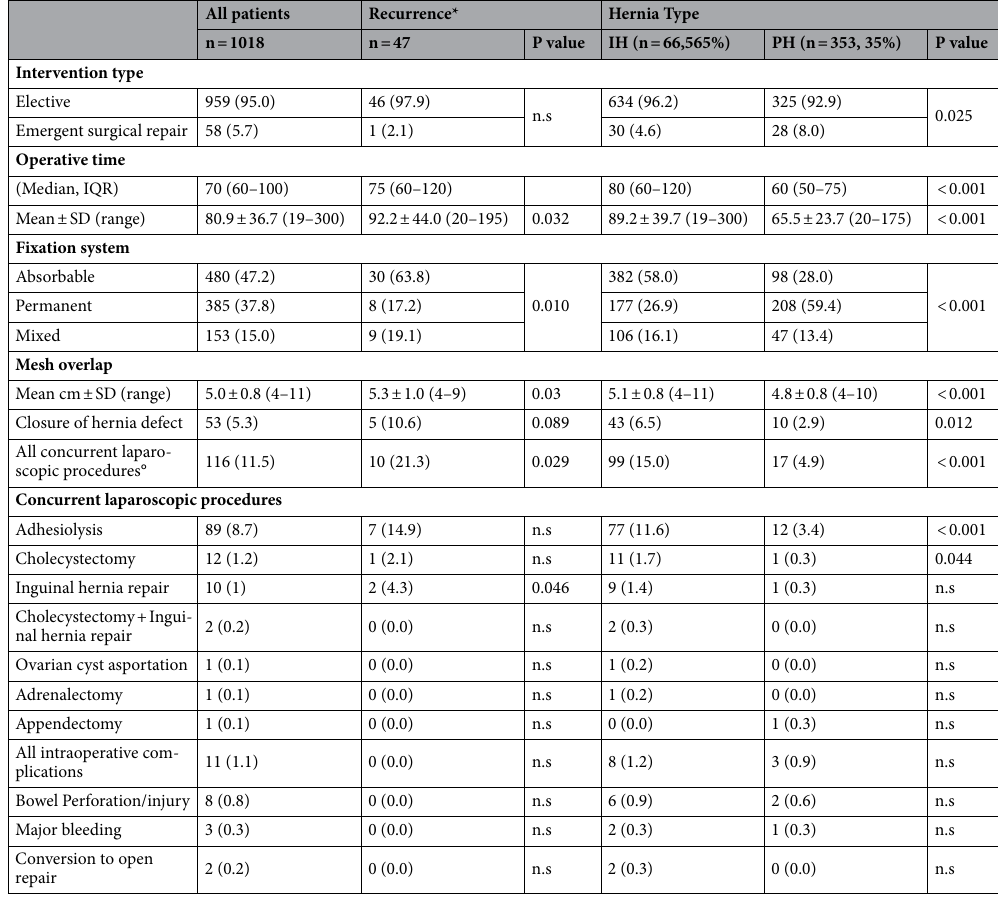
Table 2. Intraoperative details for all patients (n = 1018), recurrences* (n = 47) with significative risk factors (p value), and comparison between IH (n = 665) and PH (n = 353). Data presented were n (%), unless specified. n.s. , not significative. *Comparison with all patients without recurrence (n = 971). °Including